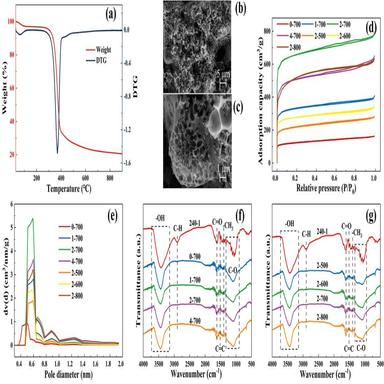
Weight loss curves of hydrothermal biochar (a); SEM images (b, c), N2 adsorption-desorption curves (d), pore size distribution (e), and FTIR spectra (f, g) of activated biochar.